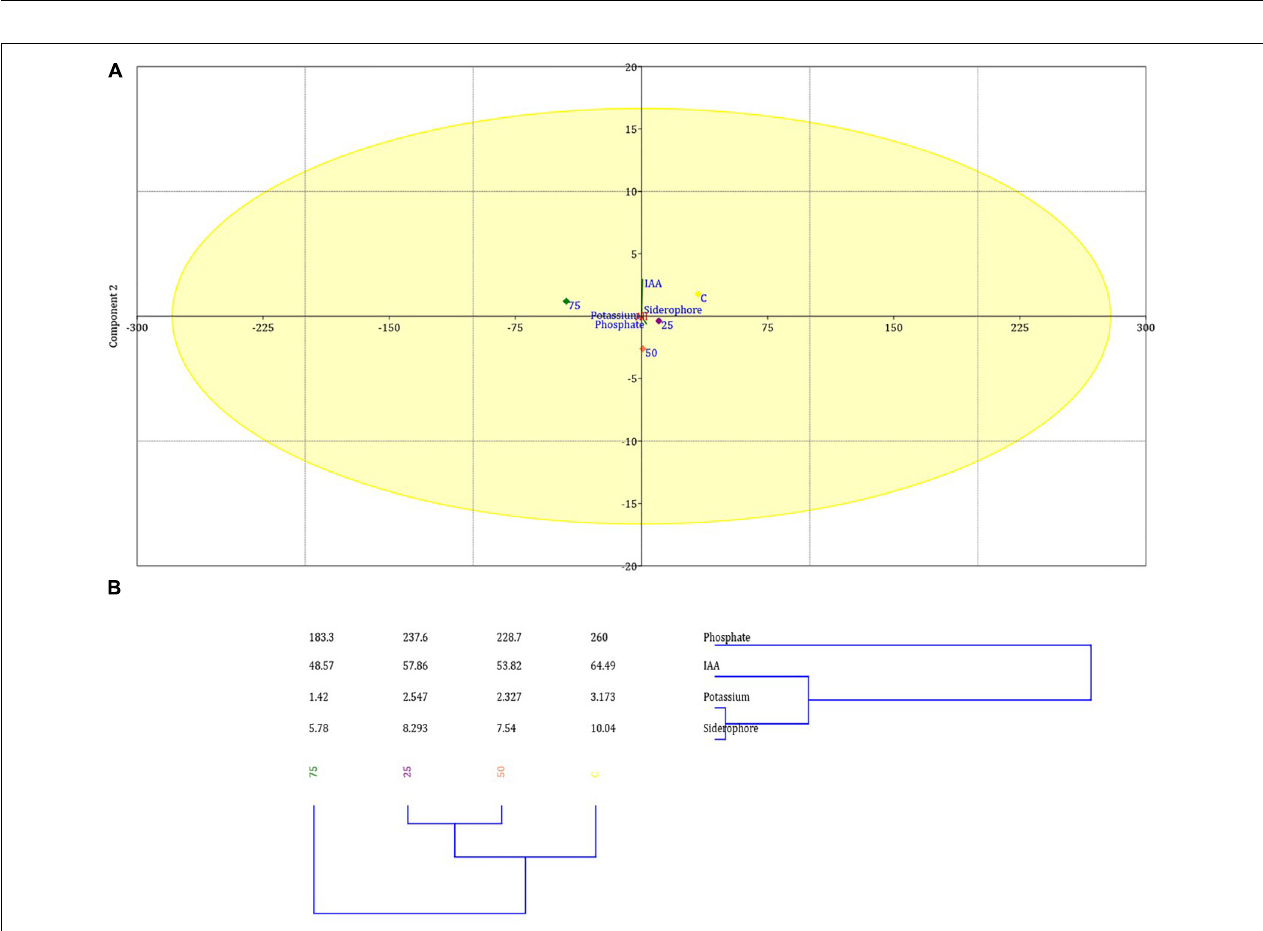
Frontiers in Microbiology |